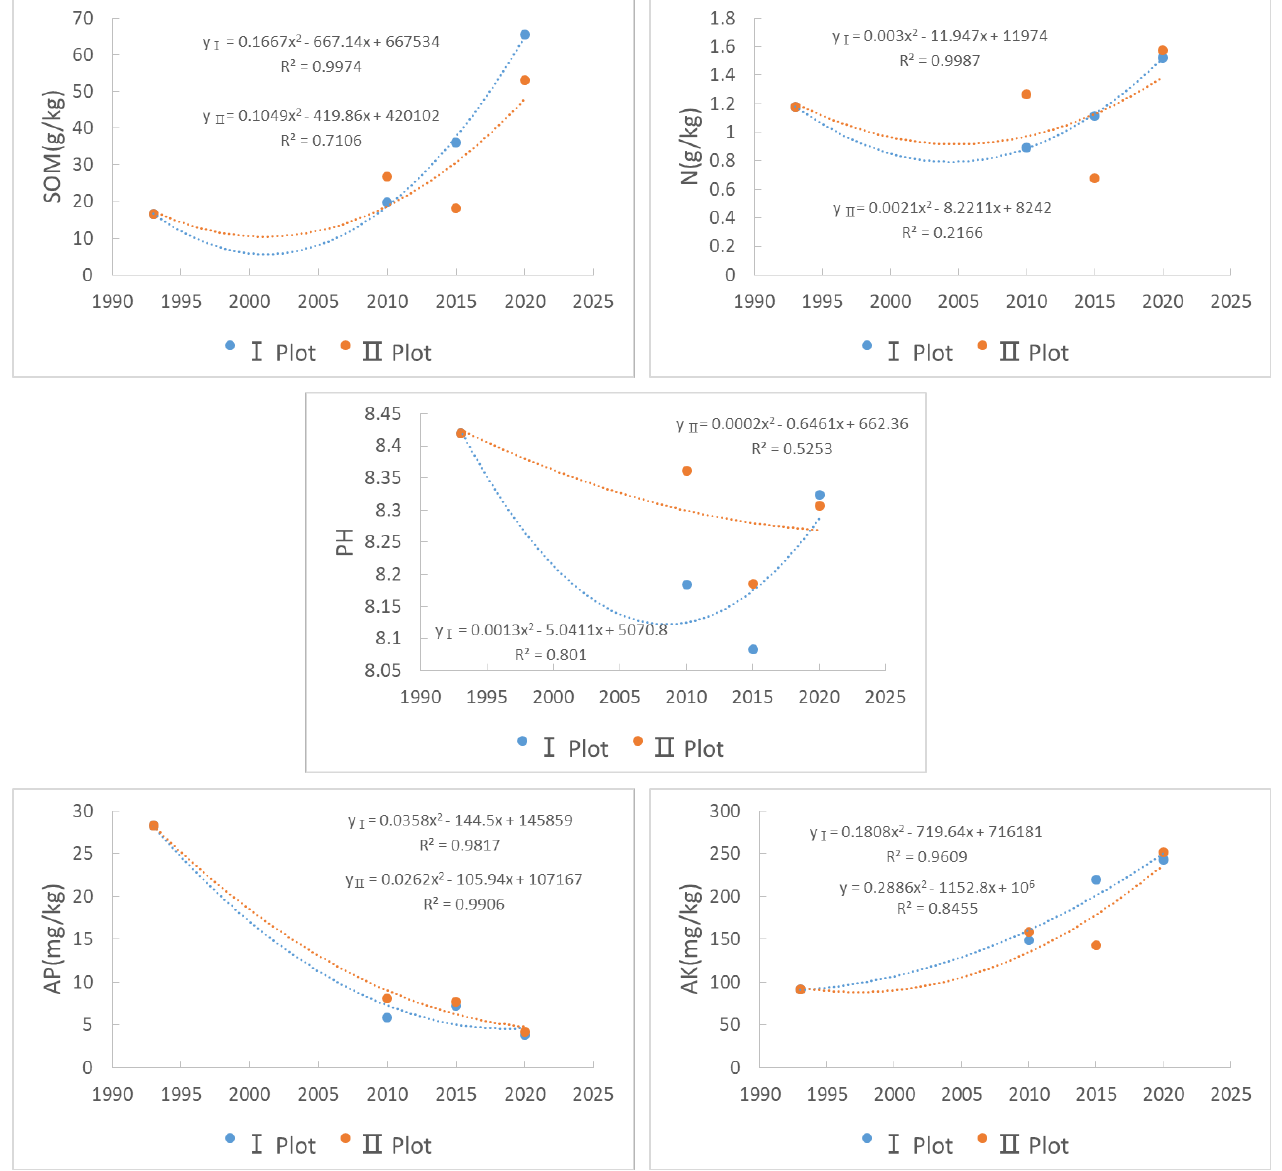
Figure 5. Soil index dynamics.